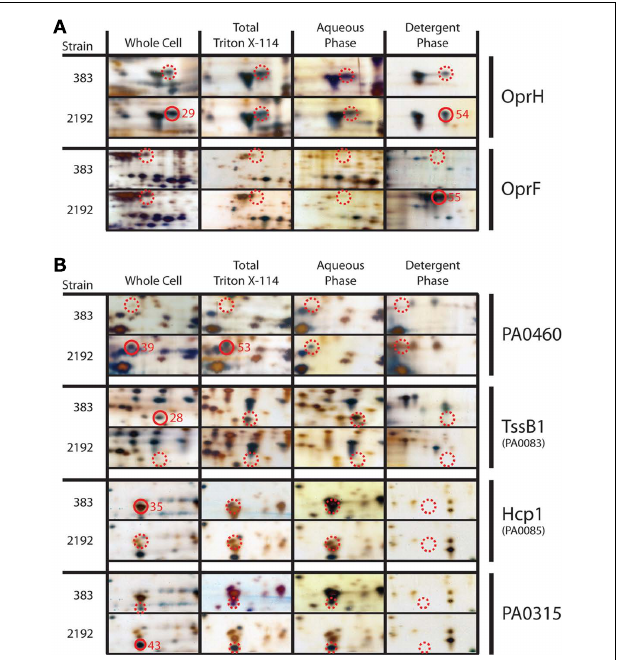
FIGURE 3 |Two-dimensional gel protein analysis of strains 383 and 2192. (A) Indicates outer-membrane proteins that were analyzed and (B) indicates other proteins of interest. Samples are designated as follows: whole cell total soluble extract, totalTriton X-114 soluble extract, aqueous phase extract and detergent phase extract. Approximately 15 μ g of total protein was focused in a 3–10 (NL) IPG strips using a PROTEAN IEF cell (Bio-Rad). Second dimension, focused IPG strips were placed onto 8–16% SDS-PAGE Criterion gel and proteins were separated by molecular size. Following electrophoresis gels were silver stained and stored in distilled water with 0.5% acetic acid. Closed red circles represent cored spots with the core numbers indicated whereas dashed red circles indicate the location of spots for comparison that were not cored or MS identified. Closed and dashed red circles are indicated smaller on PA0315 panels to indicate the protein spot precisely due to a closely co-migrating spot. All cored protein spots indicated were the most abundant protein in the sample as determined by peptide mass mapping ( Table S2 in Supplementary Material) except spot 43, which corresponds to